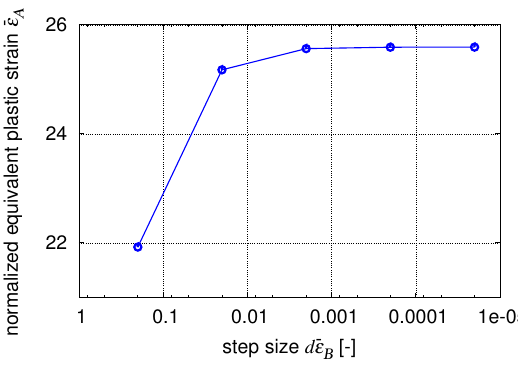
Figure 3. Convergence of the numerical method (strain normalized with respect to the mean uniform